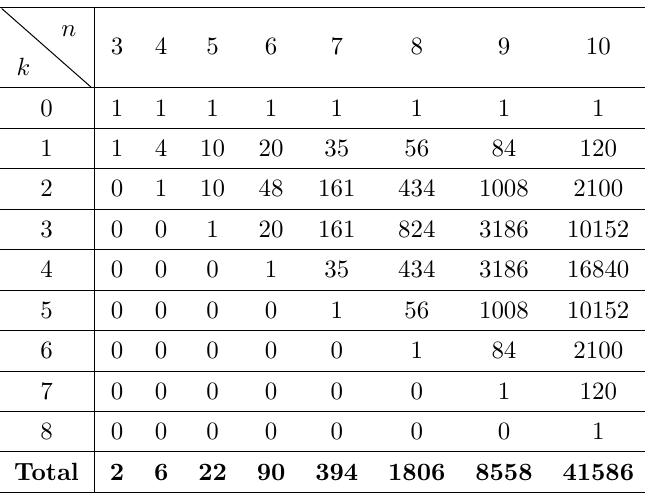
Table 1 . The number of generalised triangles for n <